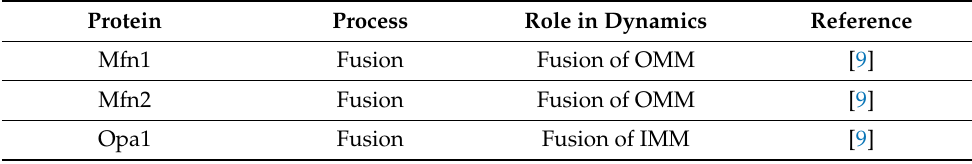
Table 1. Proteins responsible for mitochondrial dynamic